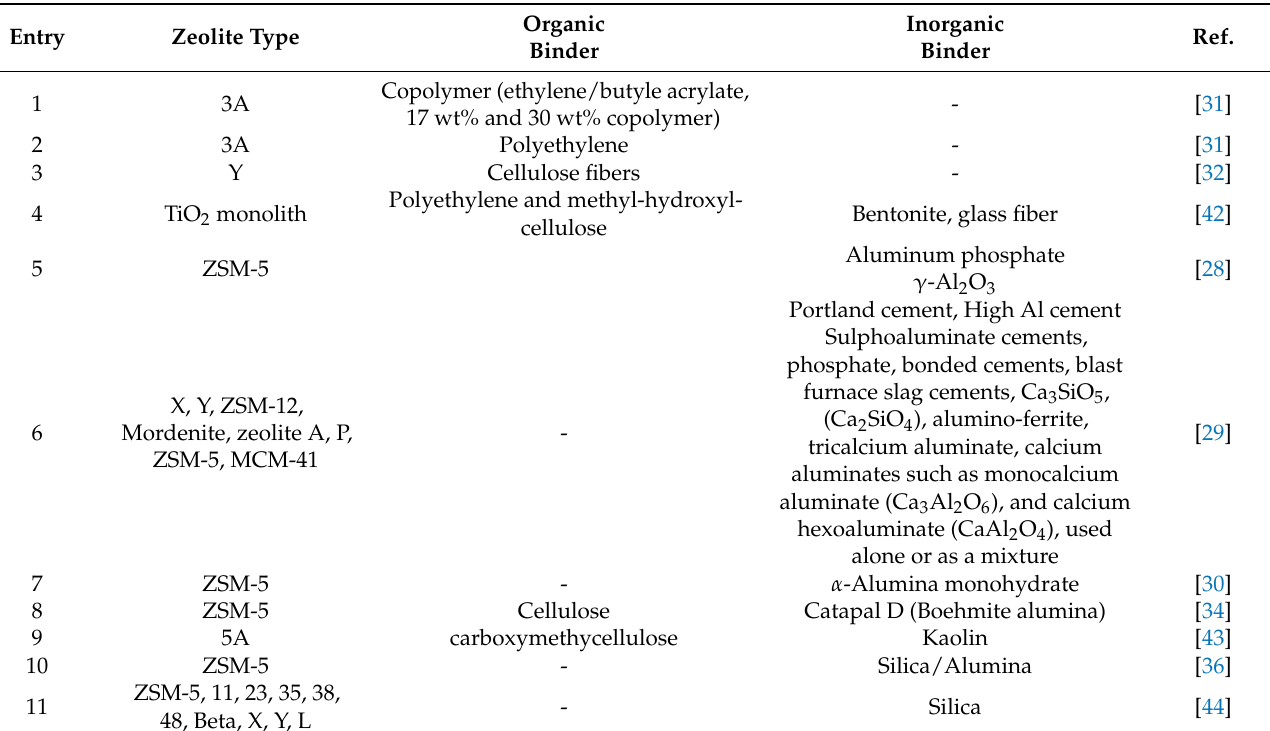
Table 1. A list of selected organic/inorganic